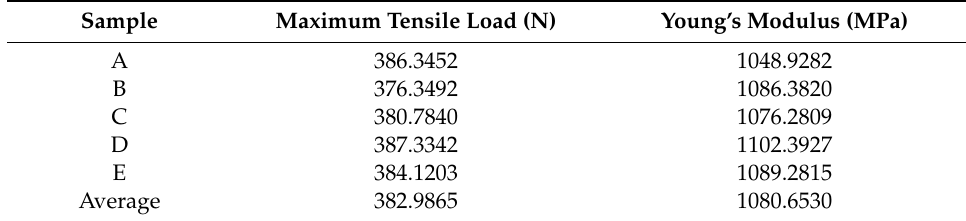
Table 4. 30% alumina powder PDMS composite carbon fiber belt.